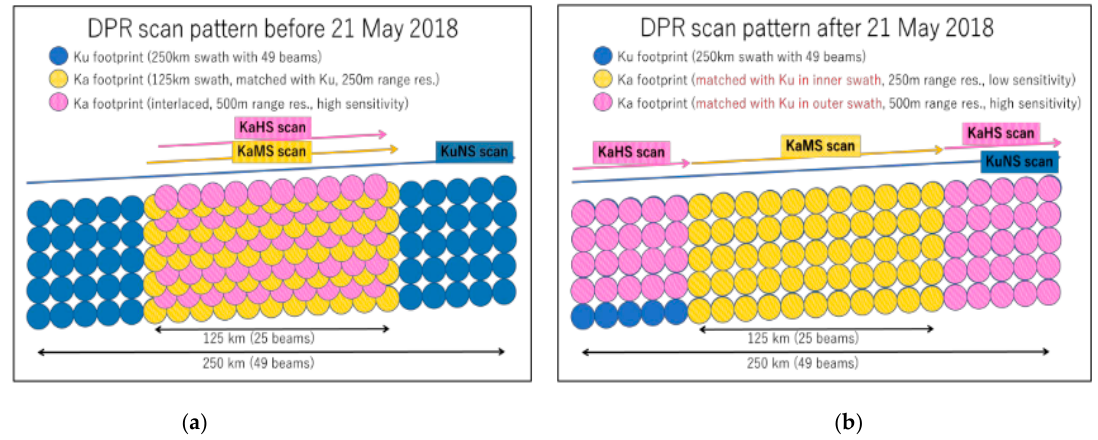
Figure 2. Scan pattern of GPM DPR: ( a ) before 21 May, 2018 and ( b ) after 21 May, 2018. Blue circles indicate Ku-band precipitation radar (KuPR) footprints, while yellow and pink circles represent a matched (KaMS), and highly sensitive (KaHS) swath of Ka, respectively [17].